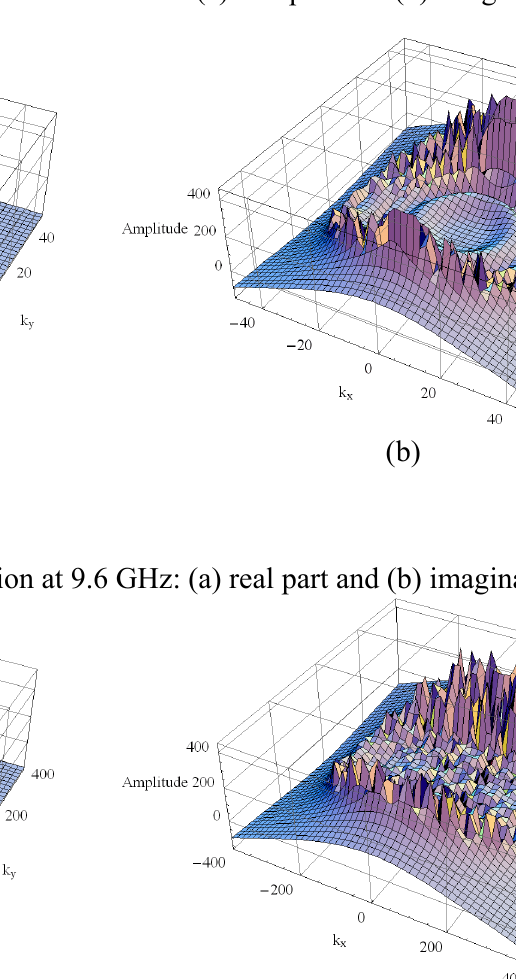
Figure 3. The 3-D Green’s function at 1.25 GHz: (a) real part and (b) imaginary part.